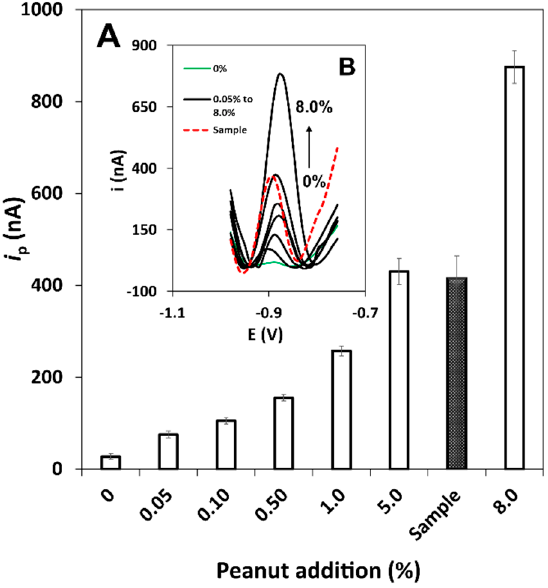
Figure 5. ( A ) Results of the analysis of Ara h 1 in extracts of unspiked cookie (gluten- and allergen- free product) and spiked with increasing percentages of raw peanut (0.05, 0.10, 0.50, 1.0, 5.0 and 8.0% (m/m)), and comparison with a peanut-containing cereal bar (5.5% (m/m)). ( B ) Representative DPASV voltammograms.